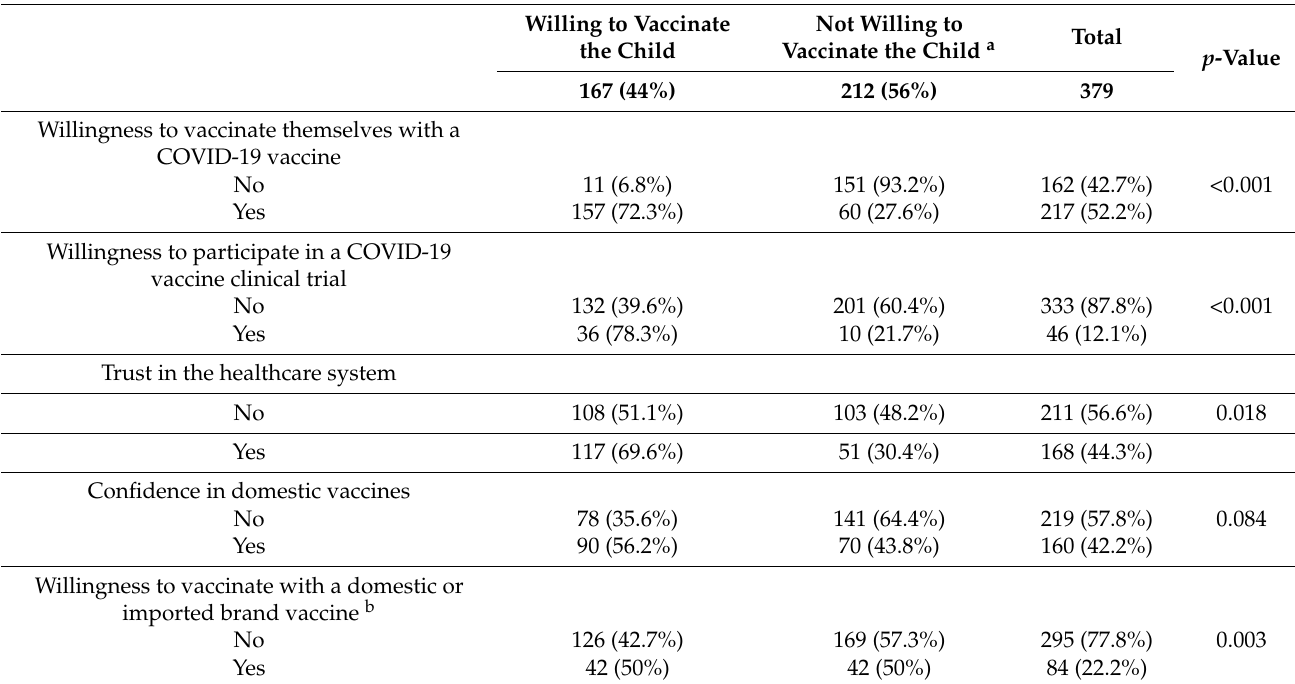
Table 3. Parents’ attitudes and opinions associated with their willingness to vaccinate their children with a COVID-19